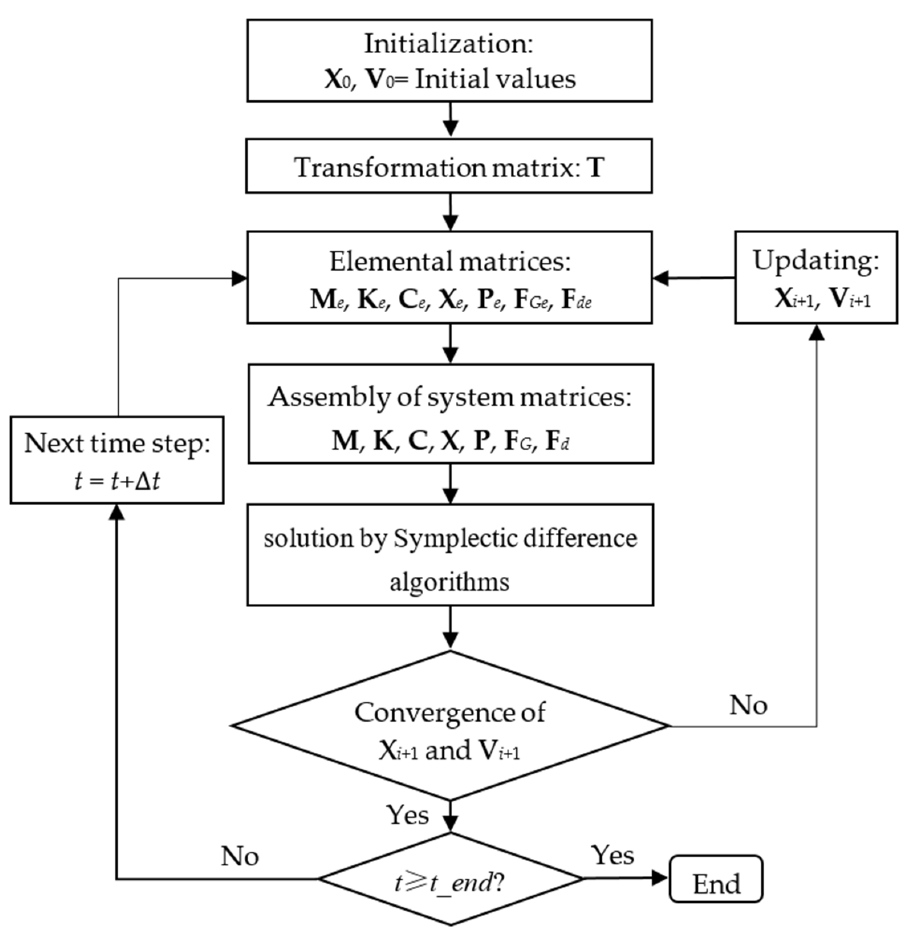
Figure 2. Flow chart of the proposed numerical procedure.